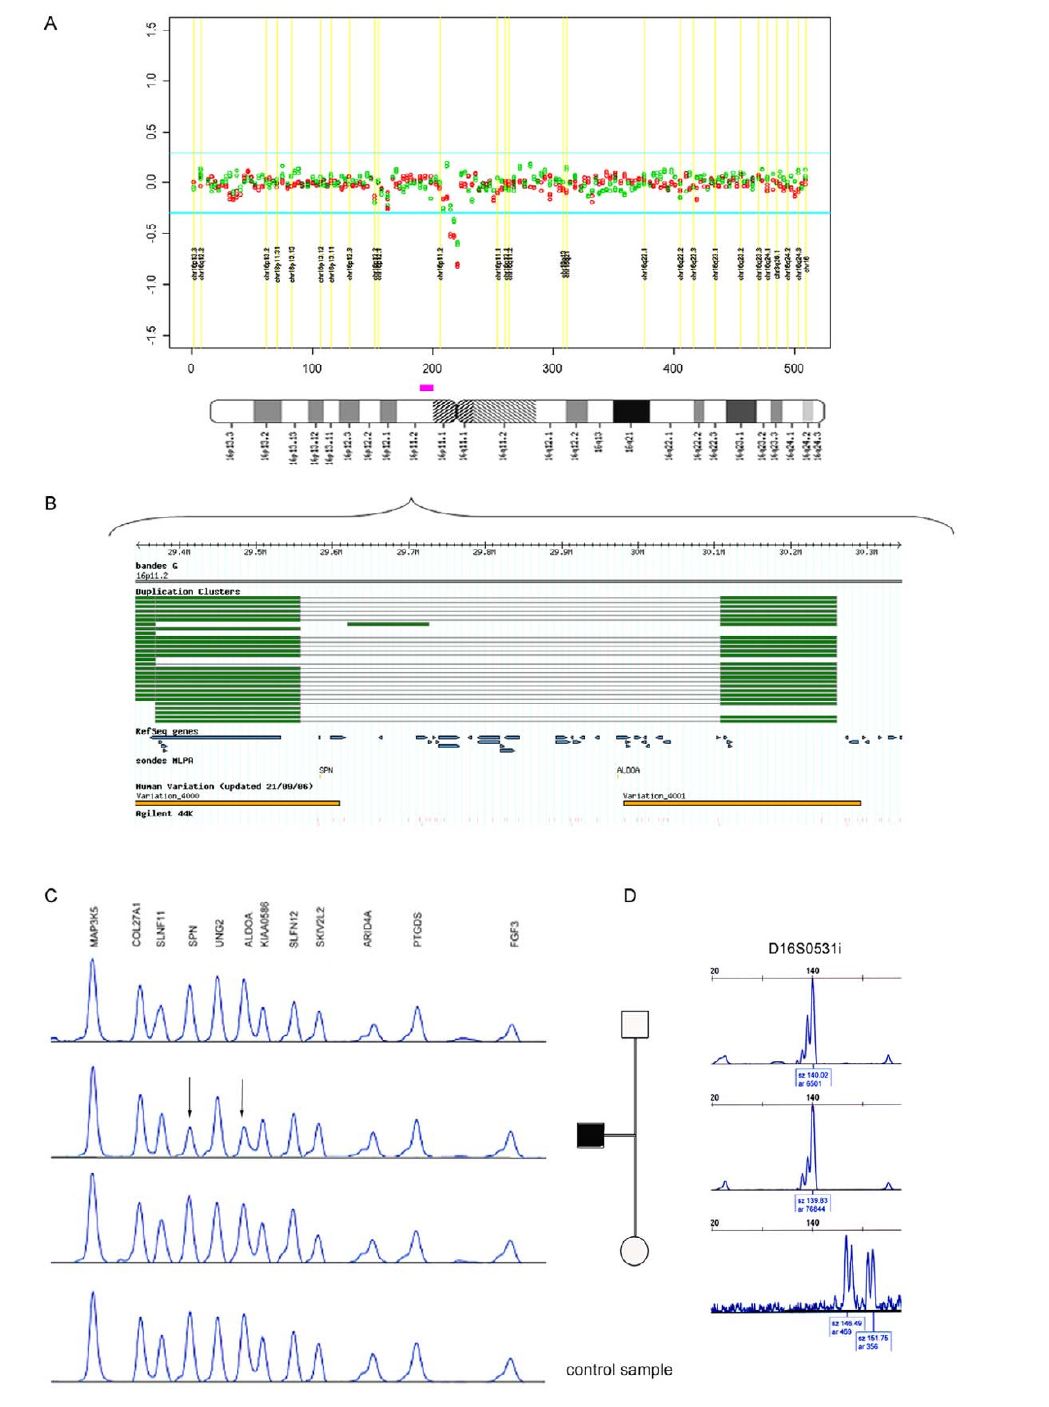
Figure 4 Detection and validation of 16p11.2 deletion in KS14. A and B: Plot of M-Values of clones on chromosome 16 and ide- ogram showing the deleted interval in the patient. C: Deletion patterns of MLPA at specific 16p11.2 probes ( SPN and ALDOA genes) showing the de novo event in the patient with respect to parental samples and a control. D: Microsatellite analysis show- ing the maternal origin of the de novo